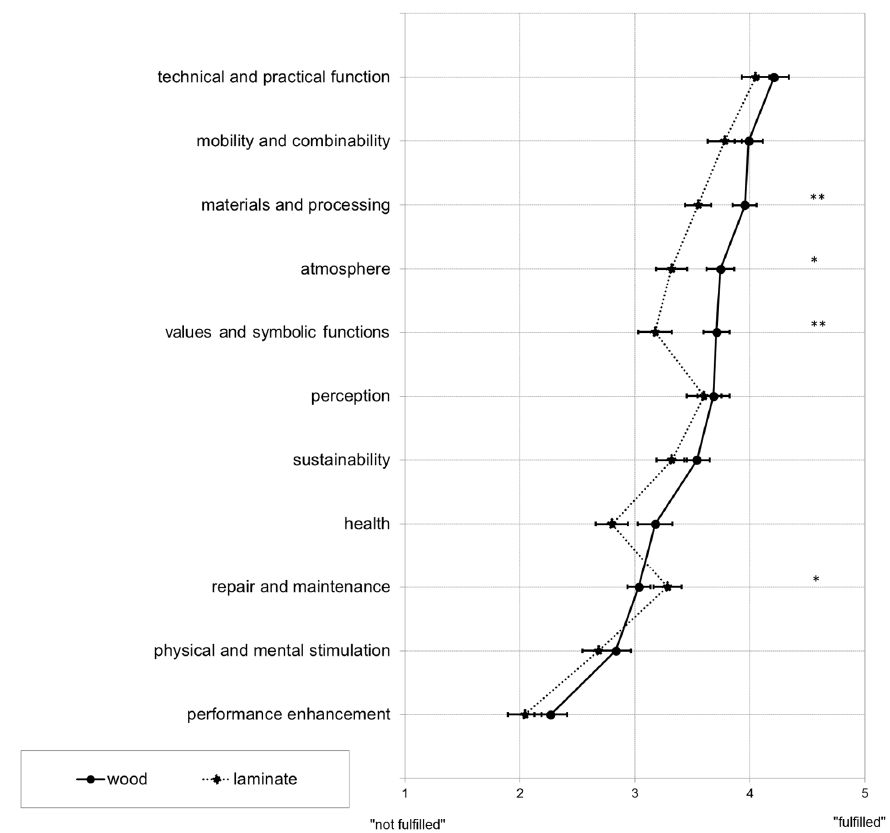
Figure 2. Evaluation of the quality criteria scales (QCC-green) for wood and laminate floor with mean and standard error for all subscales. Note: ** significant at p < 0.01; * significant at p < 0.05.